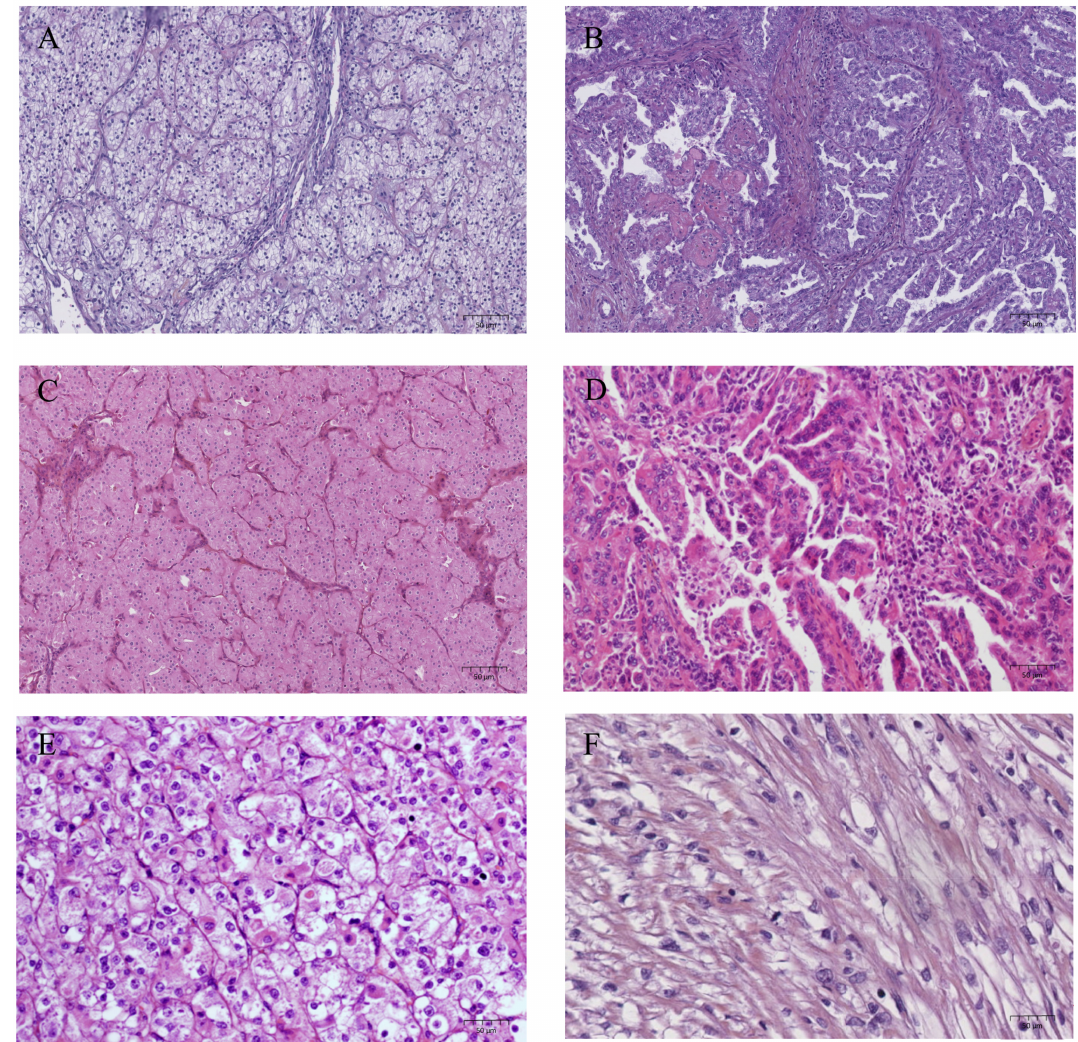
Figure 1. Histological features of renal cell carcinoma, HES staining, x200. ( A ) clear cell renal cell carcinoma, ( B ) papillary renal cell carcinoma, ( C ) chromophobe renal cell carcinoma, ( D ) TFE3 translocation renal cell carcinoma, ( E ) TFEB translocation renal cell carcinoma, ( F ) sarcomatoid